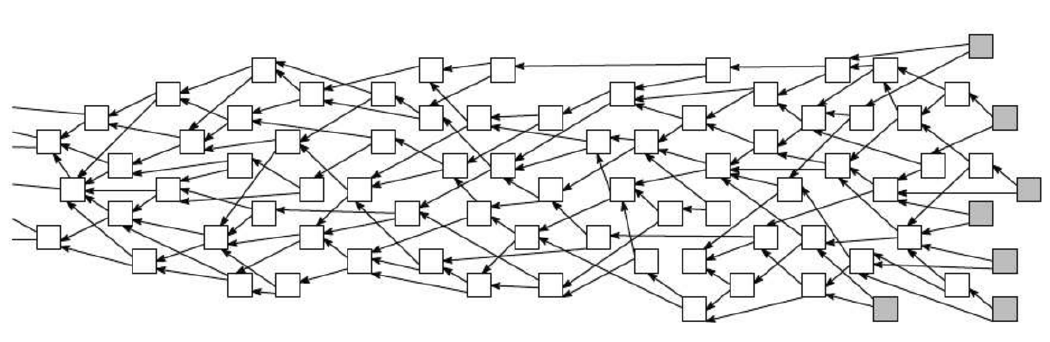
Figure 2. IOTA’s ledger, “The Tangle”. The graph’s edges are the transactions while the vertices indicate the transactions that are referenced [5].